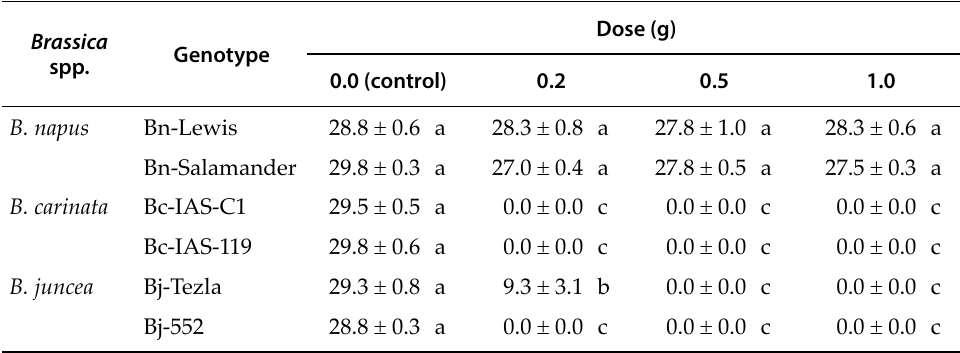
Table 3. Maximum radial growth (± SE) of Phytophthora cinnamomi colonies on CA medium after 3 d exposure to volatiles released by different Brassica spp. biofumigant seedmeals. Values accompanied by different letters differ significantly ac- cording with Tukey´s HSD test ( P< 0.05).